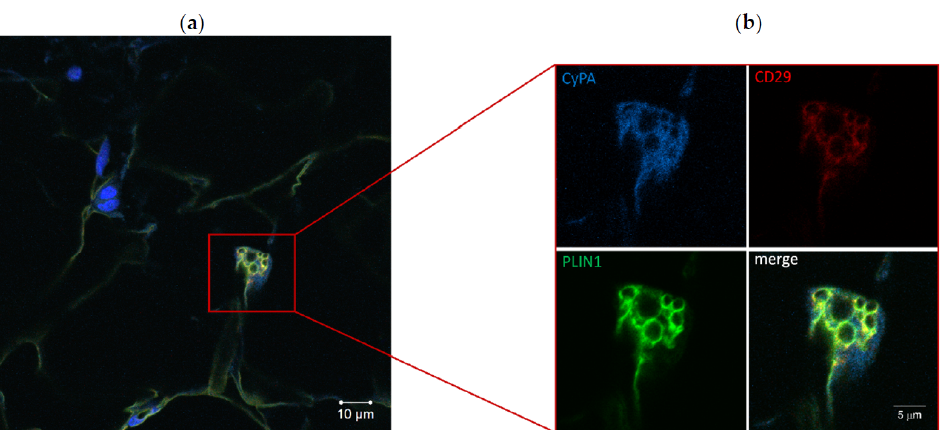
Figure 3. Immunofluorescence staining of ACM RV section ( a ). Particular of a preadipocyte, positive for CD29 and perilipin 1 (PLIN1), expressing cyclophilin A (CyPA) ( b ). The image of merged signals is also shown.